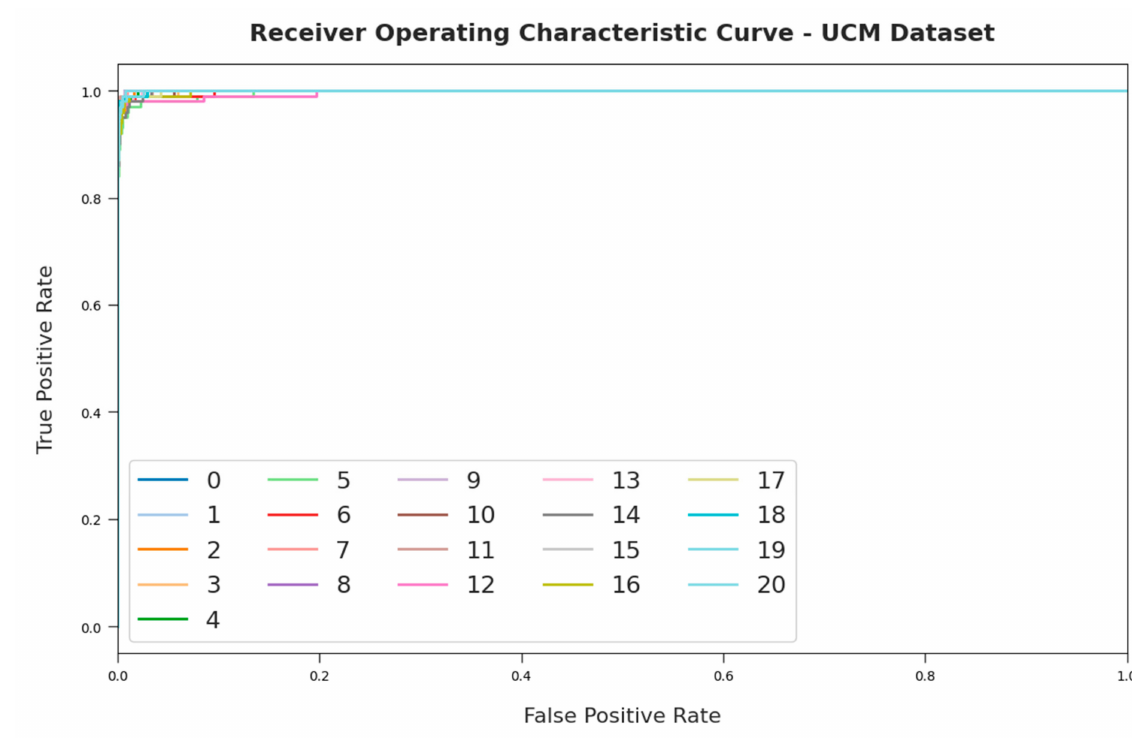
Figure 9. ROC curve analysis of SIDTLD-AIC technique on UCM